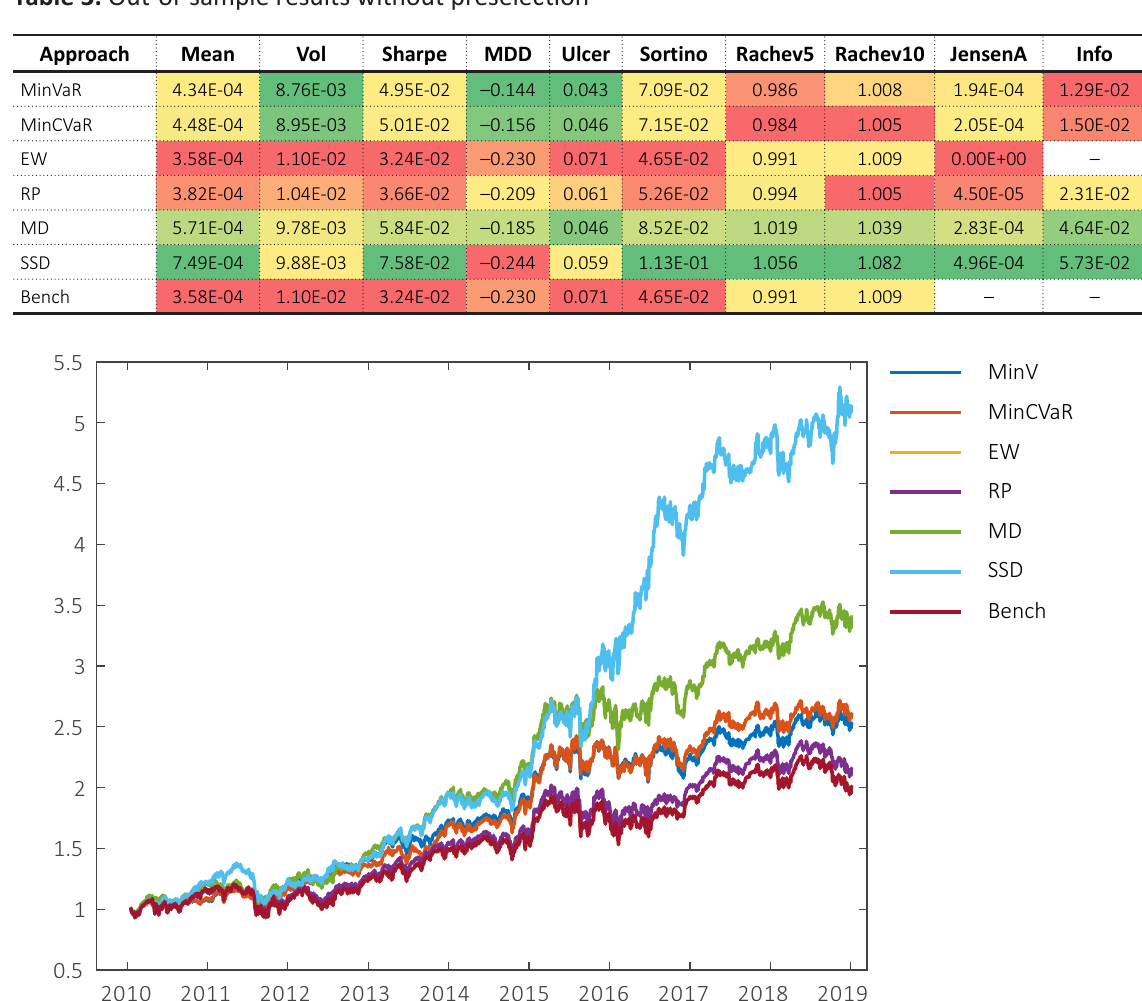
Figure 3. Out-of-sample compounded return for all models without preselection